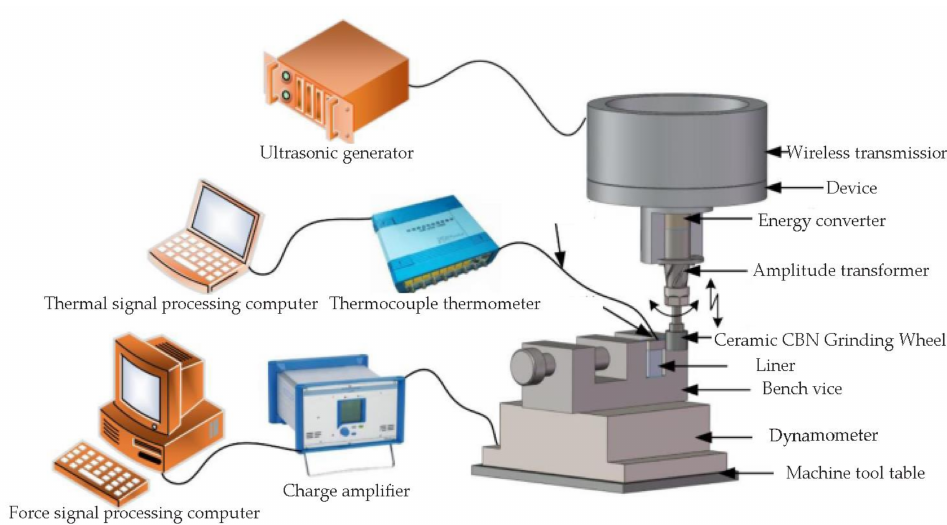
Figure 6. The working principle of force and thermocouples.